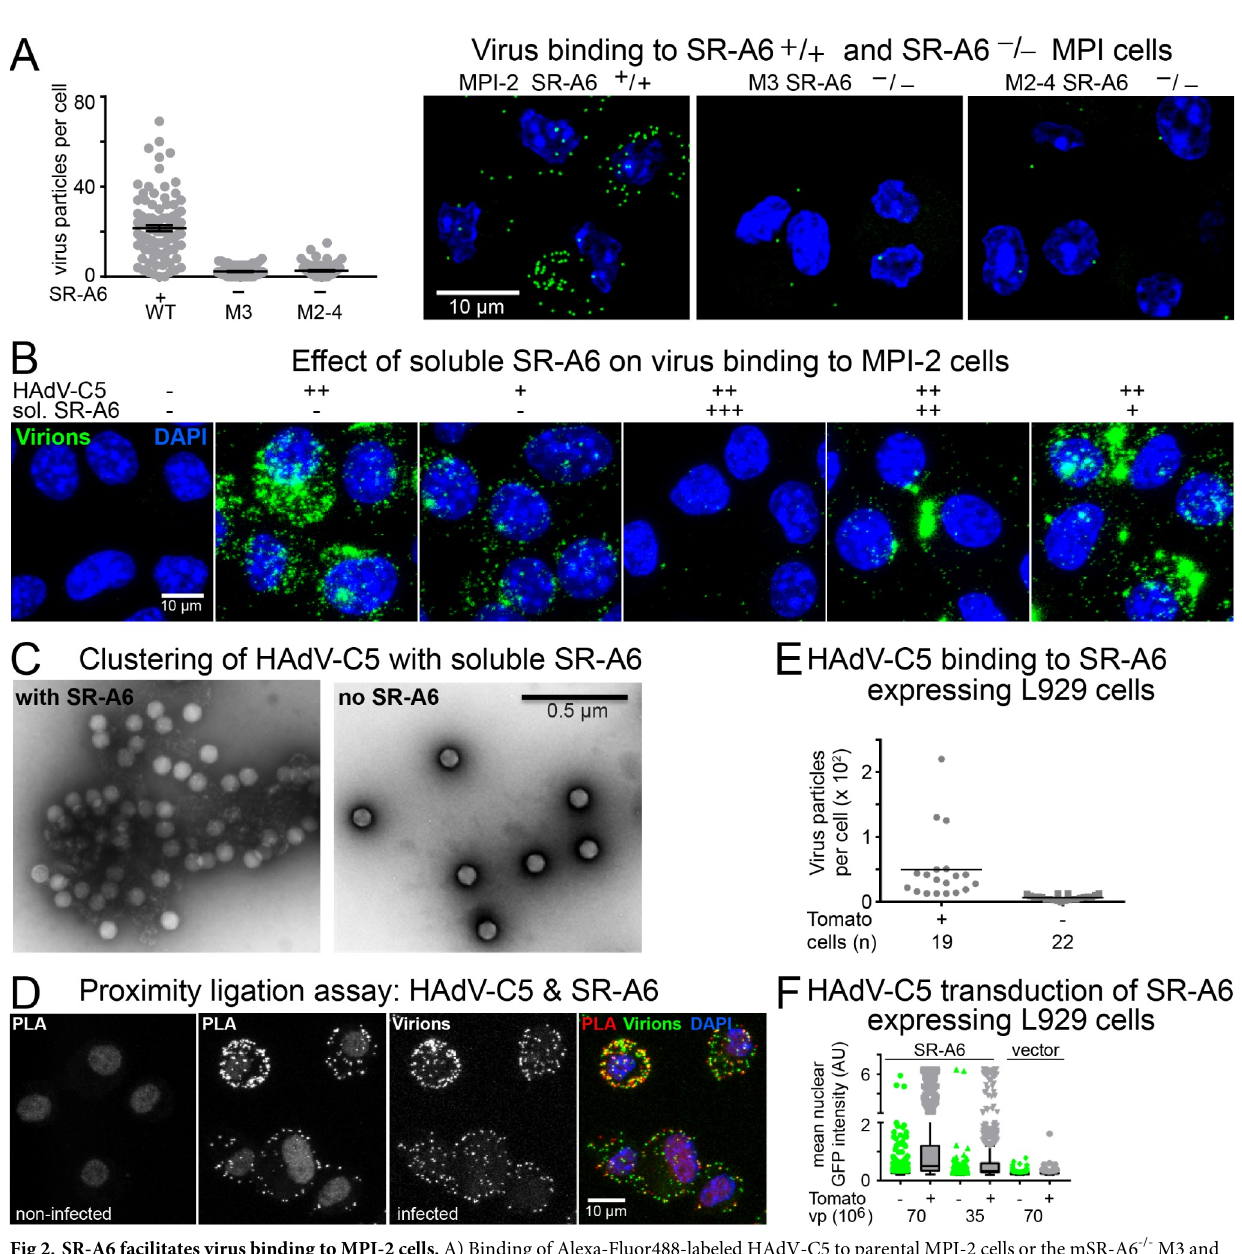
Fig 2. SR-A6 facilitates virus binding to MPI-2 cells. A) Binding of Alexa-Fluor488-labeled HAdV-C5 to parental MPI-2 cells or the mSR-A6 -/- M3 and M2-4 cell lines. Virus was added to cells at +4˚C for 60 min (moi ~ 2540 virus particles per cell) and cells were shifted to 37˚C for 5min before analysis. The plot shows number of bound virus particles per cell, one dot representing one cell. Error bars represent the means ± SEMs. The difference between SR-A6-positive and SR-A6 knockout cells was statistically significant (P < 0.0001, Kolmogorov-Smirnov test). The right-hand panel shows representative images from the three cell lines analyzed. Images are maximum projections of confocal stacks. Virus particles are shown in green and nuclei (DAPI) in blue. Scale bar = 10 μm. B) Effect of preincubation of HAdV-C5 with three different amounts of soluble extracellular domain of mouse SR-A6. Input virus ~44600 virus particles per cell with the soluble SR-A6. The soluble form of SR-A6 in a concentration-dependent manner either suppressed virus binding to cells or caused virus to bind to cells in clustered forms. Scale bar = 10 μm. C) Representative negative stain EM images of HAdV-C5 incubated in the presence or absence of soluble, partially trimeric SR-A6. Scale bar = 0.5 μm. D) Proximity ligation assay indicates co-localization of virus and SR-A6 at the cell surface. Alexa-Fluor488-conjugated HAdV-C5 was added to cells at 4˚C for 60 min (moi ~1370 virus particles per cell), and proximity ligation assay was performed with anti-Alexa-Fluor488 antibodies and anti-SR-A6 ED31 antibody. Images shown represent maximum projections of confocal stacks. PLA indicates signal from the proximity ligation assay, virus panel shows the Alexa-Fluor488-labeled virus particles and the overlay panel demonstrates the overlap of PLA and virus signals. Nuclei (DAPI stain) are in blue. Scale bar = 10 μm. E) Exogenous expression of murine SR-A6 in L-929 cells (low level of CAR expression) promotes binding of HAdV-C5 to the cells. SR-A6 was expressed in the cells from a bi-cistronic mRNA which also directed the synthesis of Tomato from an internal translation initiation site. Alexa-Fluor488- labeled HAdV-C5 particles were bound to transfected L-929 cells at 4˚C. Fixed samples were imaged by confocal microscopy. Virus particles associated with Tomato-positive and–negative cells were scored from maximum projections